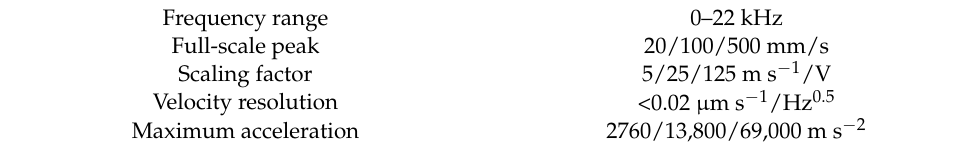
Table 2. Characteristics of the RTS Leica TS 50 measuring equipment.